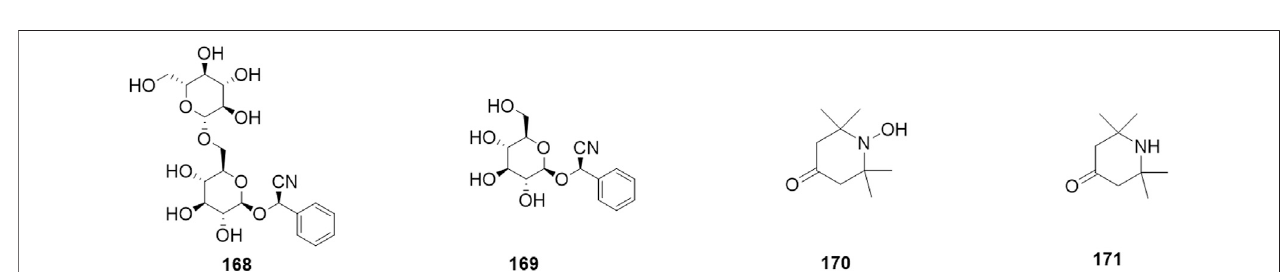
FIGURE 10 | Structures of the cyanogenic glycosides (168 – 171) form P. mume .